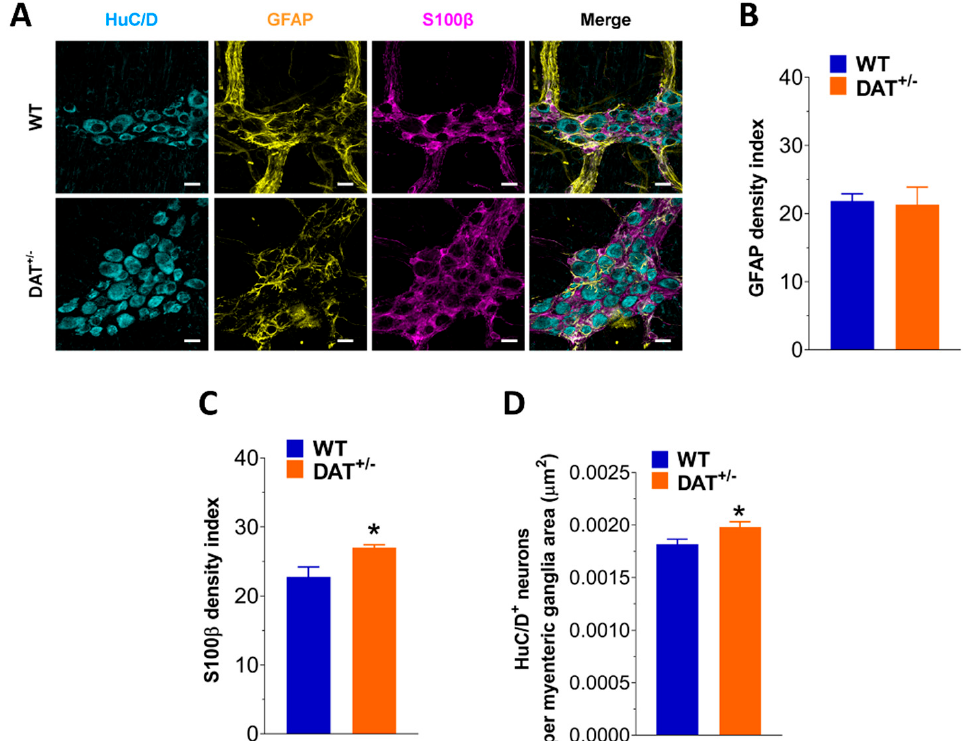
Figure 7. DAT hypofunction affects neuroglial phenotype. ( A ) Representative confocal micropho- tographs showing the distribution of HuC/D + neurons (cyan), GFAP + (yellow) and S100 β + (magenta) glial cells in WT and DAT +/ − LMMPs preparations (bars = 22 µ m). ( B,C ) Changes in GFAP ( B ) and S100 β ( C ) density index in WT and DAT +/ − LMMPs preparations. ( D ) Analysis of HuC/D + neurons in ileal LMMPs of WT and DAT +/ − mice. Data are reported as mean ± SEM. * p < 0.05 vs. WT. n = 5